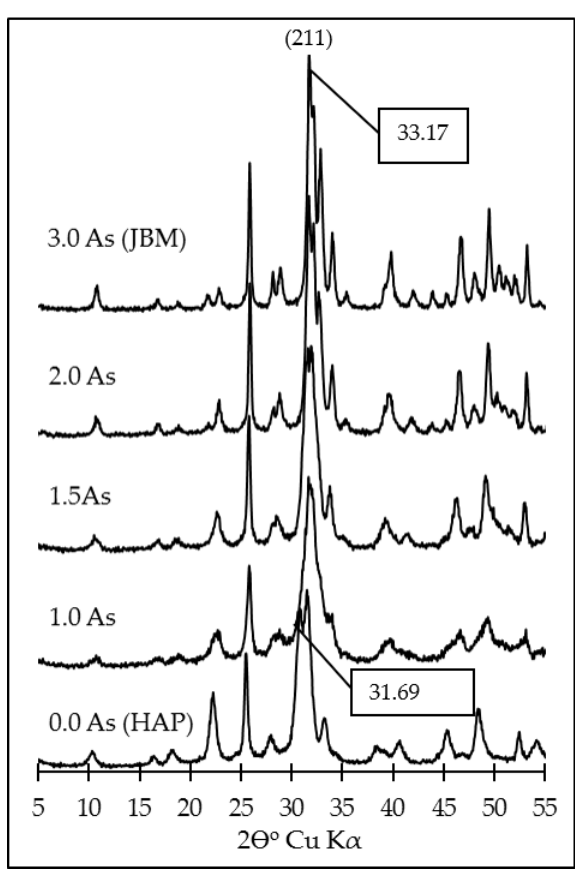
Figure 2. X-ray diffraction patterns of the synthetic johnbaumite–hydroxyapatite (JBM–HAP) solid solution series. Minerals 2018 , 8 , x FOR PEER REVIEW 6 of 20